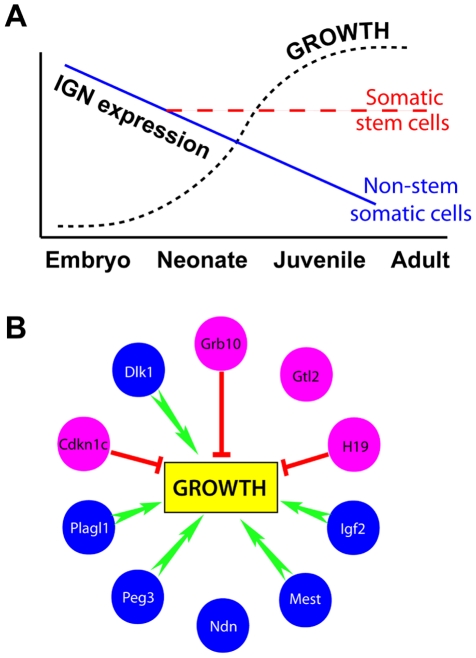
Models of IGN during development.(A) IGN members are highly expressed during embryogenesis but are downregulated in whole tissue as growth proceeds, while their expression is maintained in adult stem cell compartments. (B) Representation effects of the IGN on growth. Maternally expressed genes are depicted in pink and paternally expressed genes in blue. Overall effect on growth as determined by transgenic or knockout animal models is shown in green (promotion) or red (inhibition).